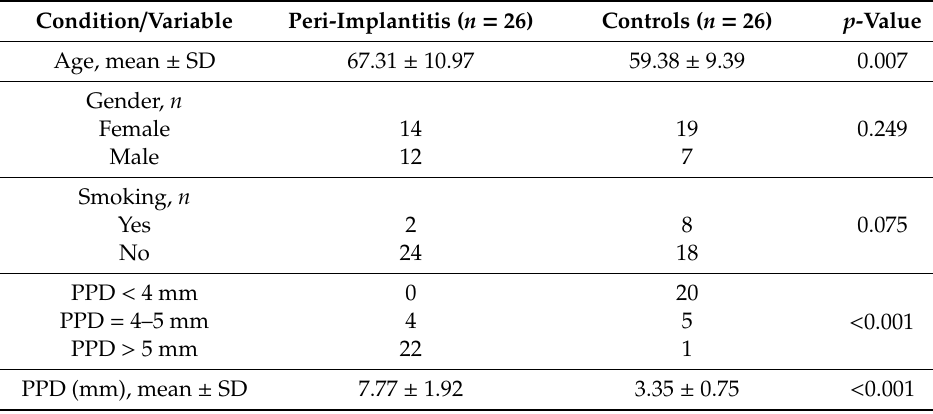
Table 1. Demographics of the study